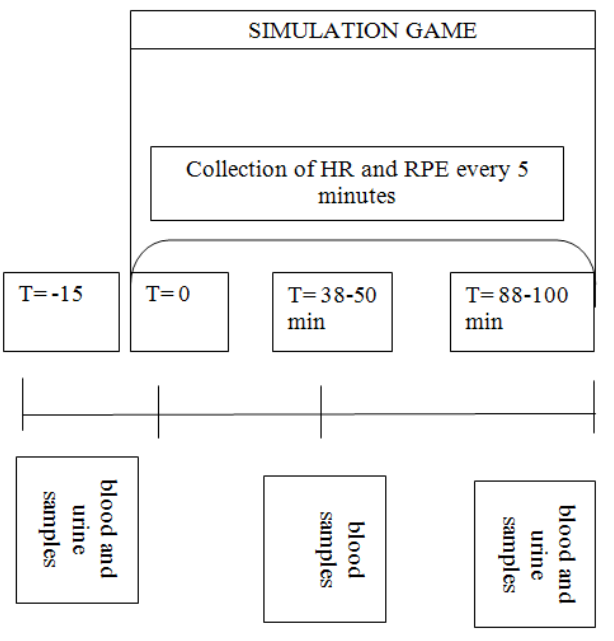
Figure 1. Chronological collection of